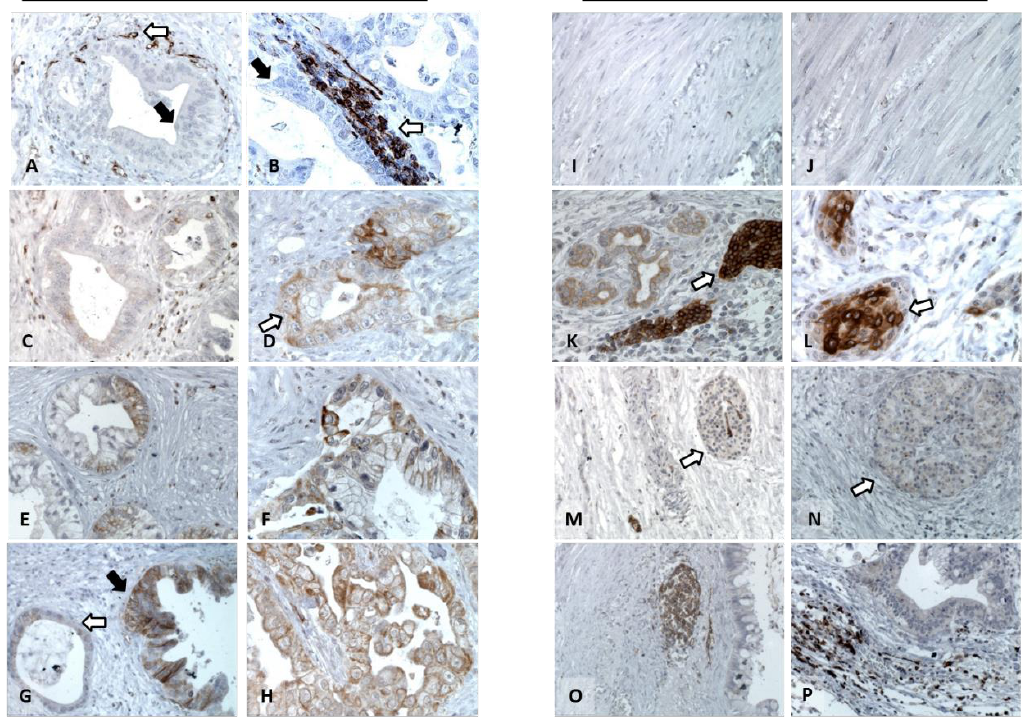
Figure 1. CXCR4 expression in epithelial and stromal PDAC cells. Representative expression in PDAC (200× and 400× magnification). Left panel: CXCR4-negative PDAC ( A ) and positive lympho-monocytic cells (white arrow) ( B ). CXCR4 low, cytoplasmic, and few membrane stainings (white arrow) ( C , D ). CXCR4 moderate expression, heterogeneous mild diffusion, and intensity of membrane and cytoplasmic ( E , F ). CXCR4 high expression, featured by a diffuse and strong membrane, cytoplasmic staining (black arrow), compared to the adjacent lesion with a low degree of cytological and architectural degeneration and low CXCR4 expression (white arrow) ( G , H ). TME analysis (right panel): Fibrotic stroma negative ( I , J ), CXCR4 expression in acinar cells (white arrow) ( K , M ). Islets of Langerhans (white arrow) ( M,N ) with faint CXCR4 surrounded by negative fibrotic stroma (white arrow), clear CXCR4 expression in lymphocytic monocytes, and endothelial infiltration ( O , P ).